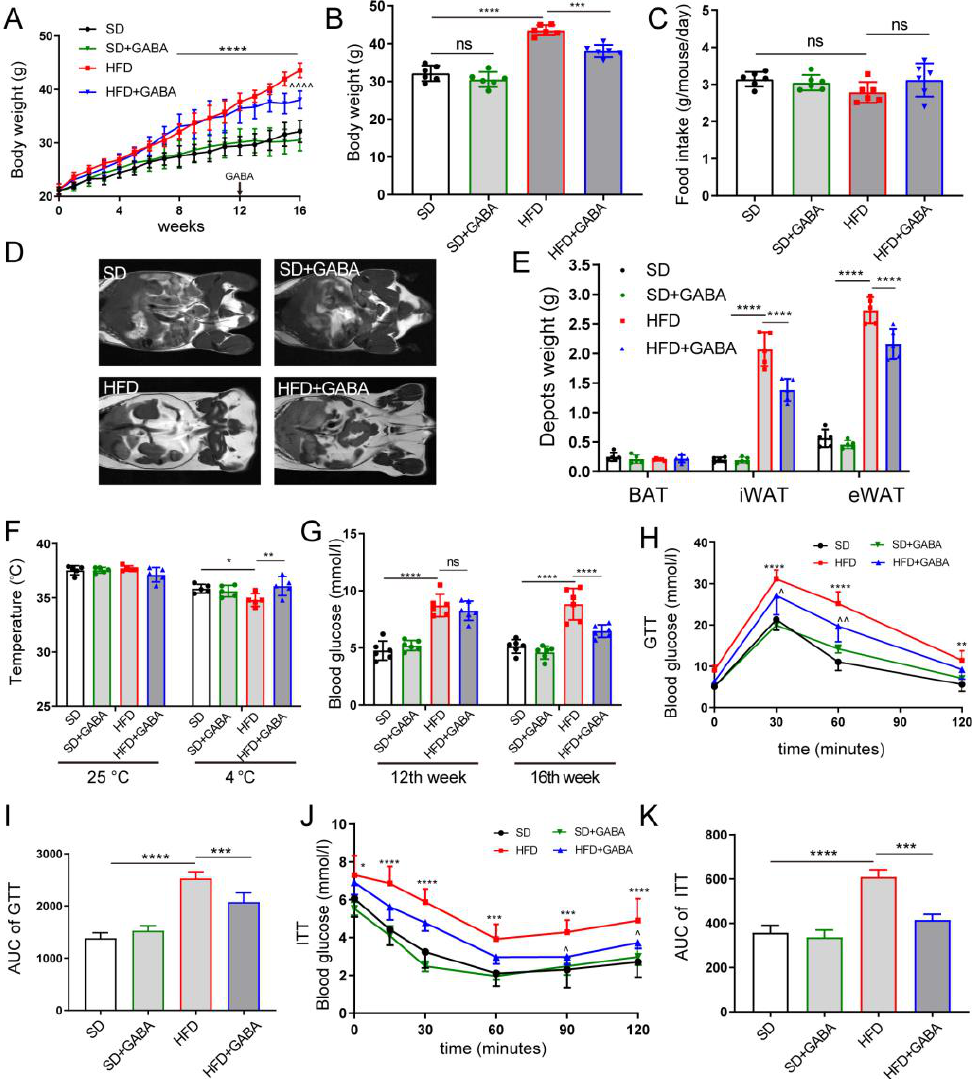
Figure 1. GABA treatment promotes energy consumption and improves glucose metabolism. Mice were administered SD (black), SD+GABA (green), HFD (red), or HFD+GABA (blue) treatment. ( A ) Changes in body weight curves of the mice over the 16 weeks of treatment. For SD+GABA and HFD+GABA group, 6 mg·mL −1 GABA was intervened at 12 weeks for a period of 4 weeks. ( B ) Body weight after the experiment. ( C ) Food intake of SD group, SD+GABA group, HFD group and HFD+GABA group. ( D , E ) MRI measurement of adipose tissue content (BAT, iWAT, and eWAT) and statistical analysis at the end of experiment. ( F ) Rectal temperature of mice in 25 ℃ (standard) or 4 ℃ (cold stimulation) for 180 min at the end of experiment. ( G ) Fast blood glucose concentrations at the 12th and the 16th week of the experiment. ( H , I ) Blood glucose concentrations during GTT ( H ), and the area under the GTT curve ( I ) at the end of experiment. ( J , K ) Blood glucose concentrations during ITT (J ), and the area under the ITT curve ( K ) at the end of experiment. Data are presented mean ± standard deviation and were analyzed using a one-way or two-way ANOVA. * p < 0.05, ** p < 0.01, *** p < 0.001, **** p < 0.0001 compared to the SD group in ( A , B , F – K ). ^ p < 0.05, ^^ p < 0.01 and ^^^^ p < 0.0001 compared to the HFD group in ( A , H , J ). n = 5–6 for all groups. Ns, not significant. ANOVA, analysis of variance; BAT, brown adipose tissue; eWAT, epididymal white adipose tissue; GABA, Gamma-aminobutyric acid; GTT, glucose tolerance test; HFD, high-fat diet; ITT, insulin tolerance tests; iWAT inguinal white adipose tissue; SD, standard diet.